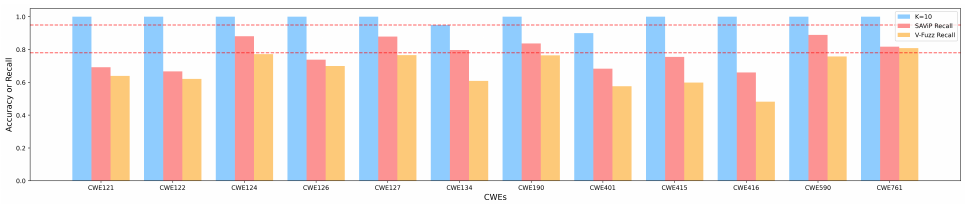
Figure 8. Model performance for different CWEs. The Top 10 accuracy of SAViP reaches 100% except for CWE134 and CWE401. For recall, SAViP outperforms V-Fuzz for all